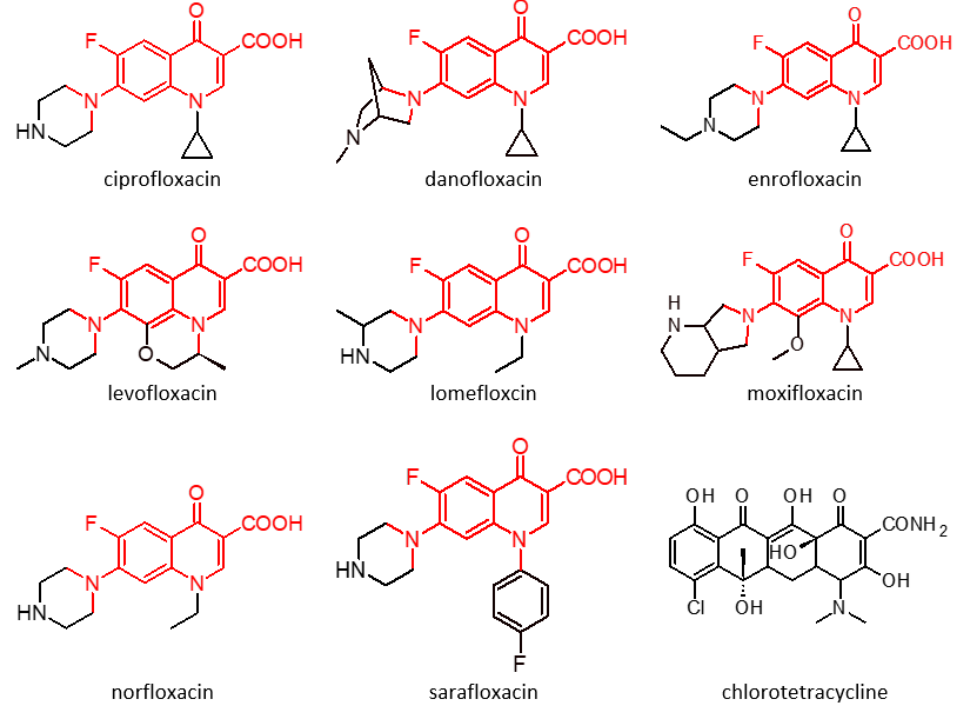
Figure 4. Effect of sample loading volumes on retention of ciprofloxacin, 200 ng mL − 1 in synthetic urine, diluted 9 + 1 v / v with 50 mmol L − 1 MES buffer, pH